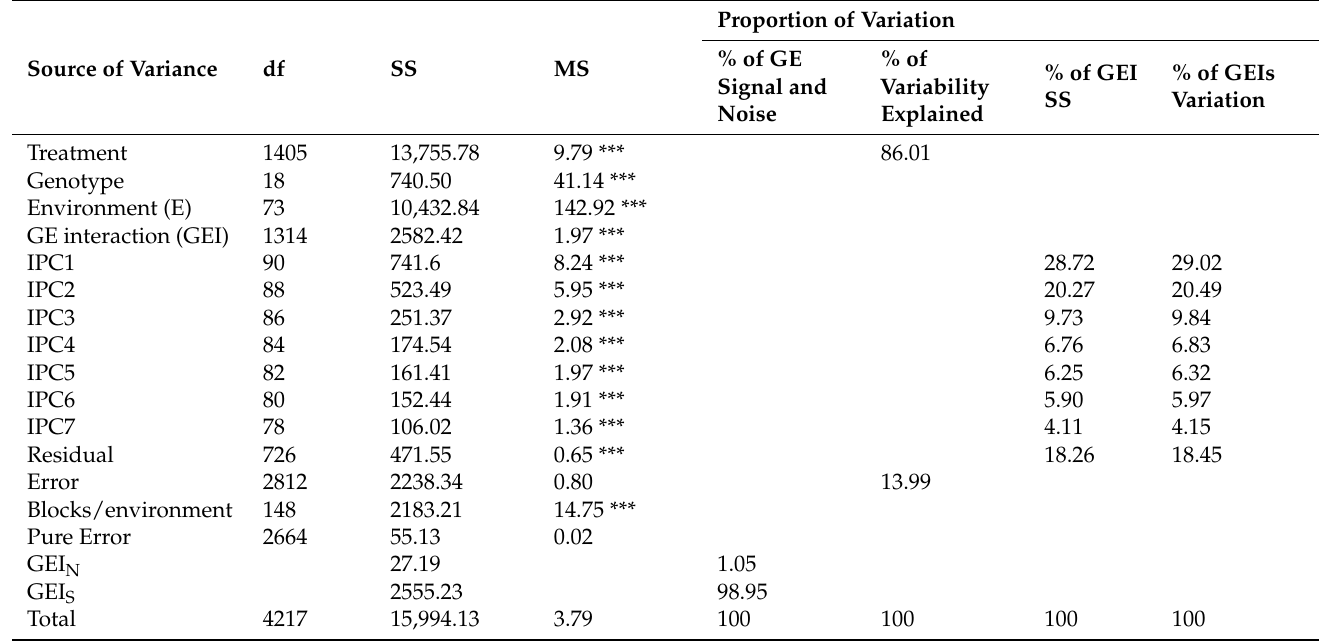
Table 3. AMMI analysis for grain yield in evaluated maize genotypes during 2018 and 2019.